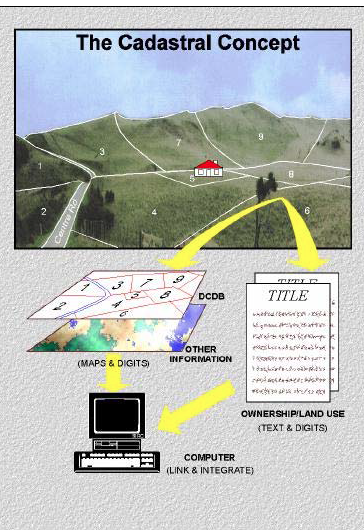
Figure 1. The overall concept of a cadastral system (FIG,